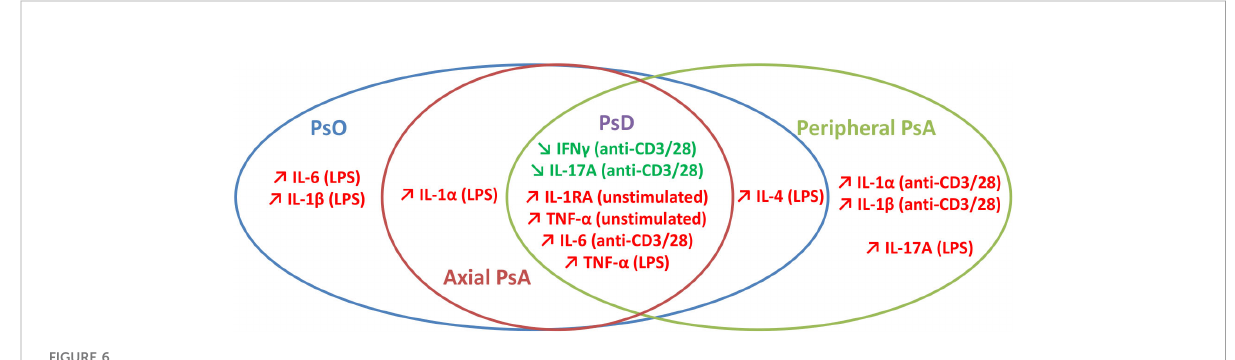
FIGURE 6 Synthetic view of discriminative ex vivo cytokine pro fi les in psoriatic